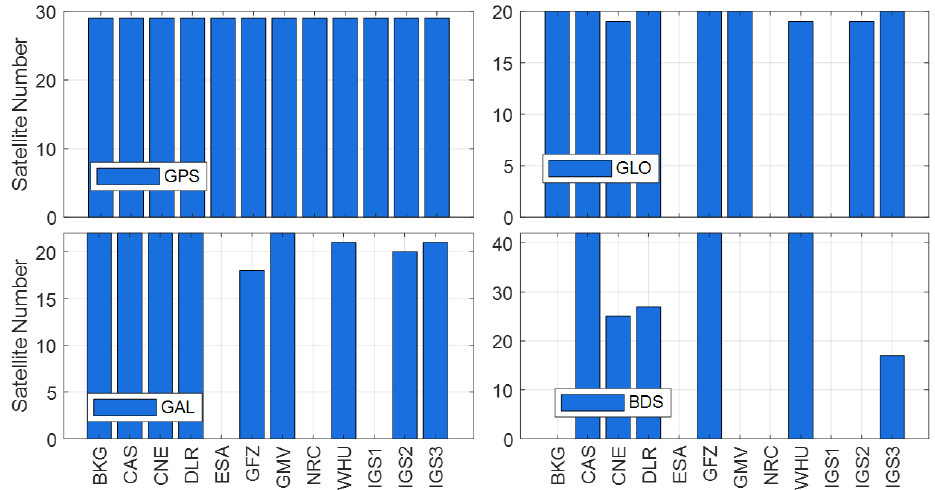
Figure 2. Satellite availability of SSR